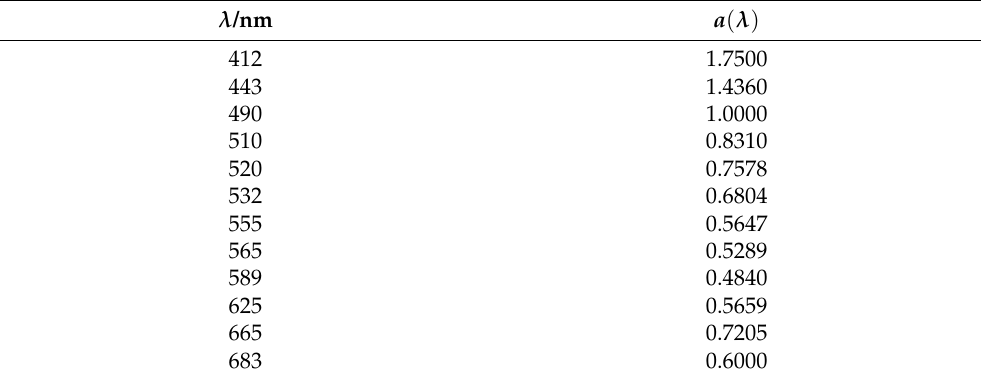
Table 1. The value a ( λ ) at selected wavebands deduced from [34] and [26] by spline interpolation